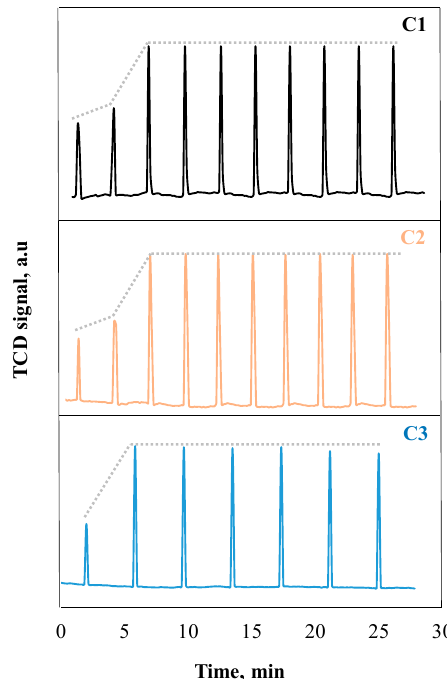
Figure 6. Thermal conductivity detector (TCD) response to CO pulse chemisorption by C1, C2 and C3. C1 and C2 saturation reached after 2 peaks (10 min), C3 saturation reached after 1 peak (3 min).